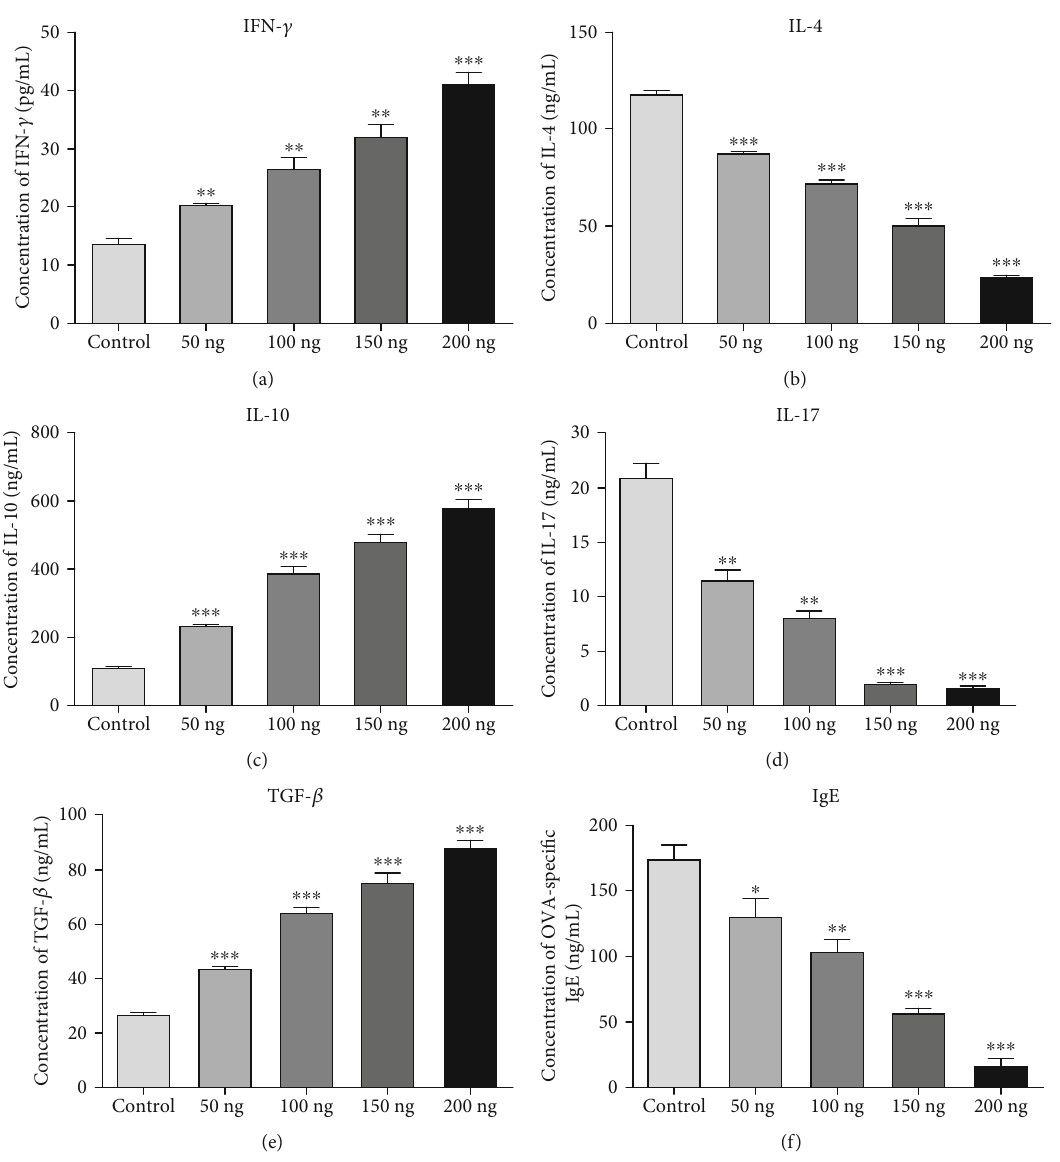
Figure 3: Cytokines were measured by ELISA in o ff spring mice from VD3-treated groups: (a) IFN- γ , (b) IL-4, (c) IL-10, (d) IL-17, (e) TGF- β , and (f) IgE from peripheral blood of o ff spring mice in VD3-treated and control groups were measured by ELISA. ∗ P < 0 : 05 vs. control, ∗∗ P < 0 : 01 vs. control, and ∗∗∗ P < 0 : 001 vs.